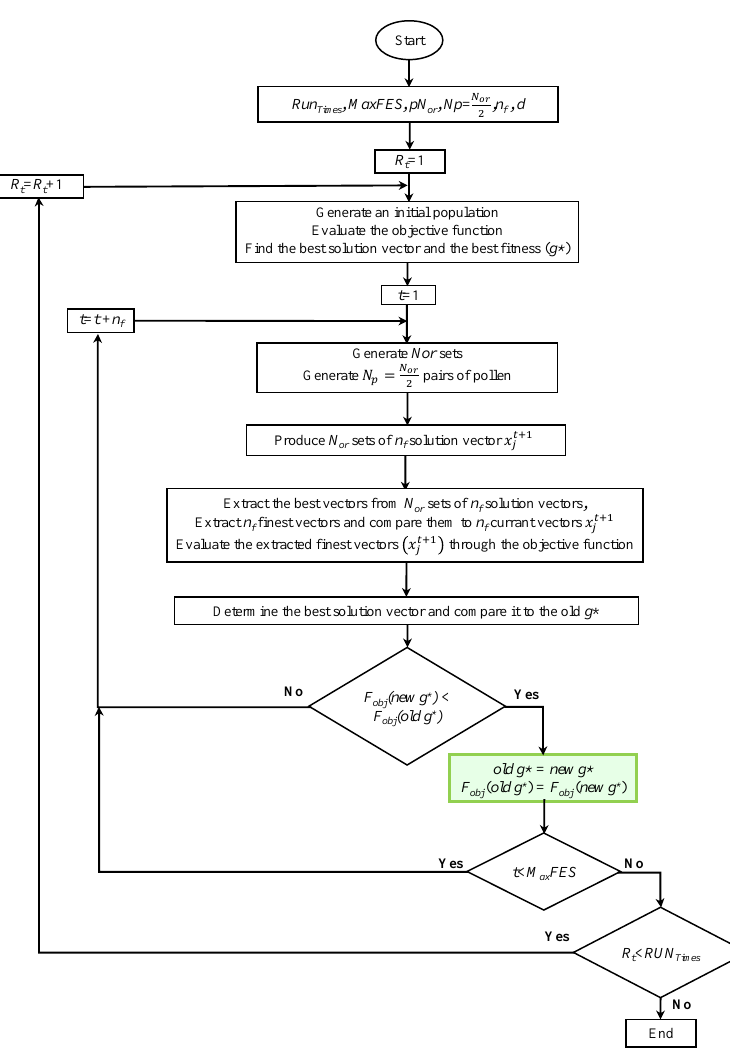
Figure 2. Flowchart of